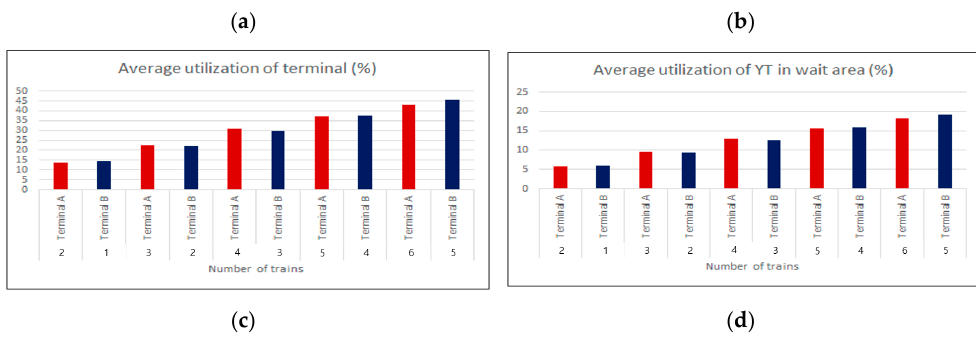
Figure 18. Simulation results for number of one-directional routes and avoidances by trains, as well as the travel times between terminals A and B, with a train operating time of 18 h: ( a ) number of containers on the train; ( b ) average waiting time of the train; ( c ) average utilization of the terminal; ( d ) average utilization of a yard tractor in the waiting area.